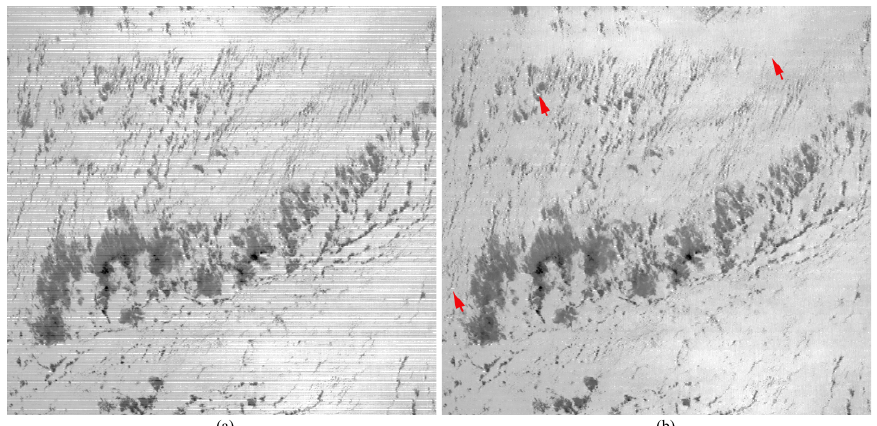
Figure 27. Limitations. An example of proposed model failure to remove fragile stripe. ( a ) original striped MODIS data; ( b ) the output of